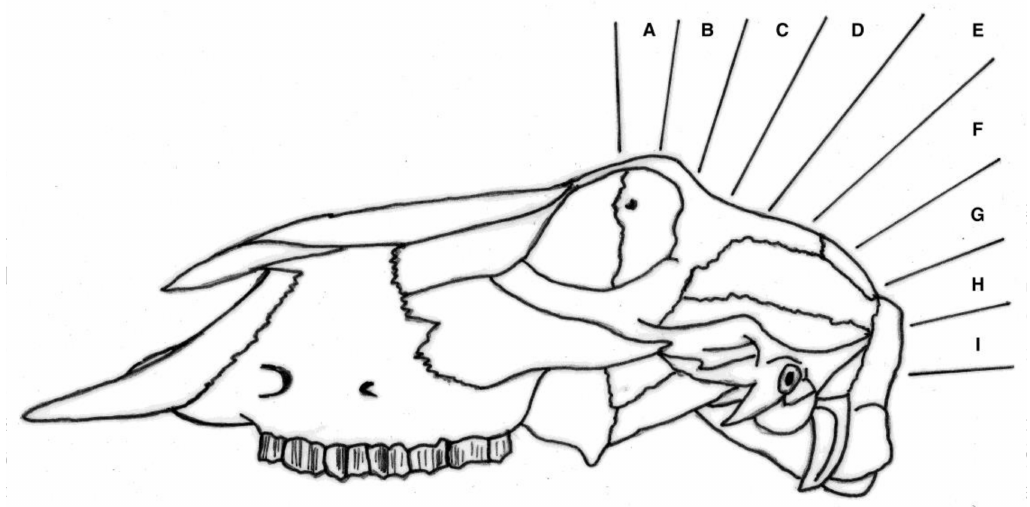
Figure 3. Sagittal targeting areas using surface topography with F representing a shot on the frontal-parietal suture, G on the parietal bone, H on the parietal-occipital suture